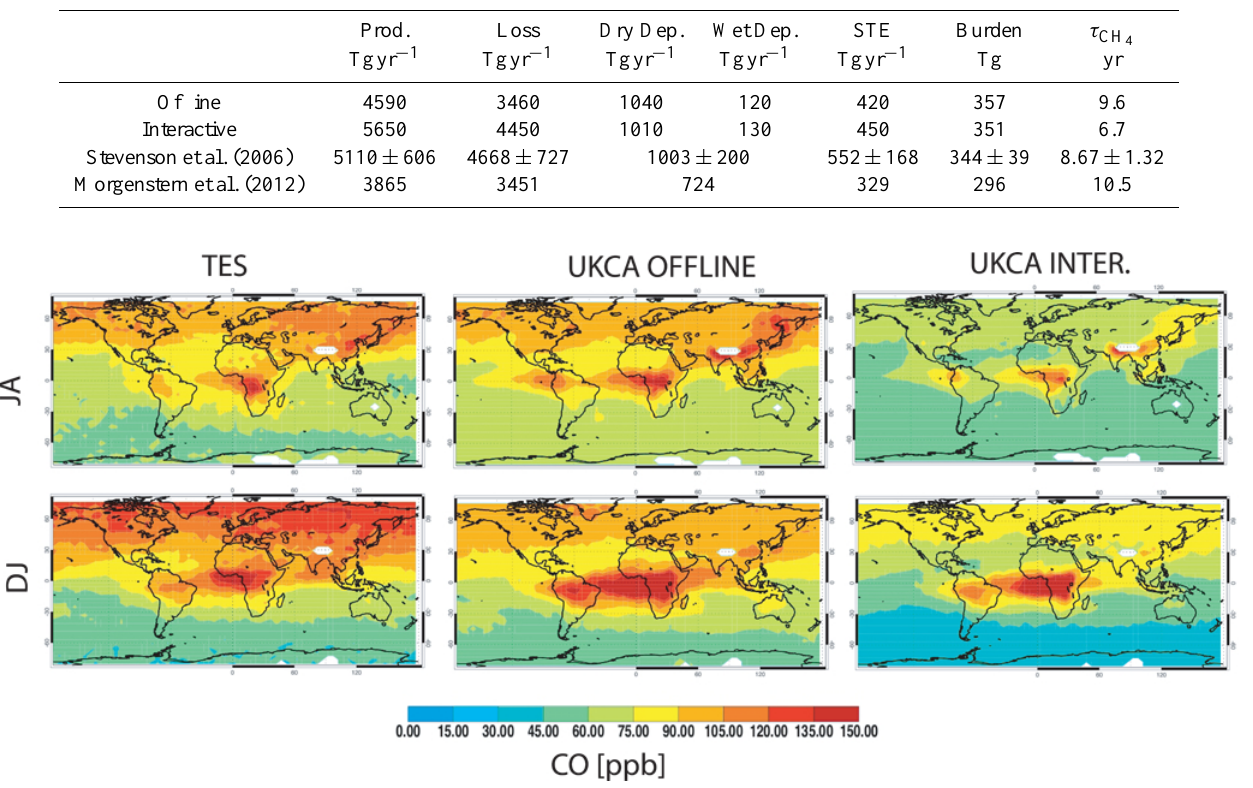
Fig. 5. Carbon Monoxide (ppbv) averaged over 800–400hPa from 2005–2008 July/August (top row) and December/January (bottom row). Left column: observations from TES. Middle column: model with offline photolysis. Right column: model with interactive